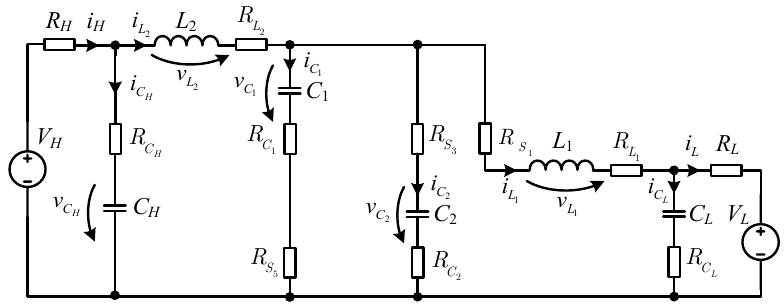
Figure 15. Equivalent BHSC schematic, derived from Figure 14, for t on .